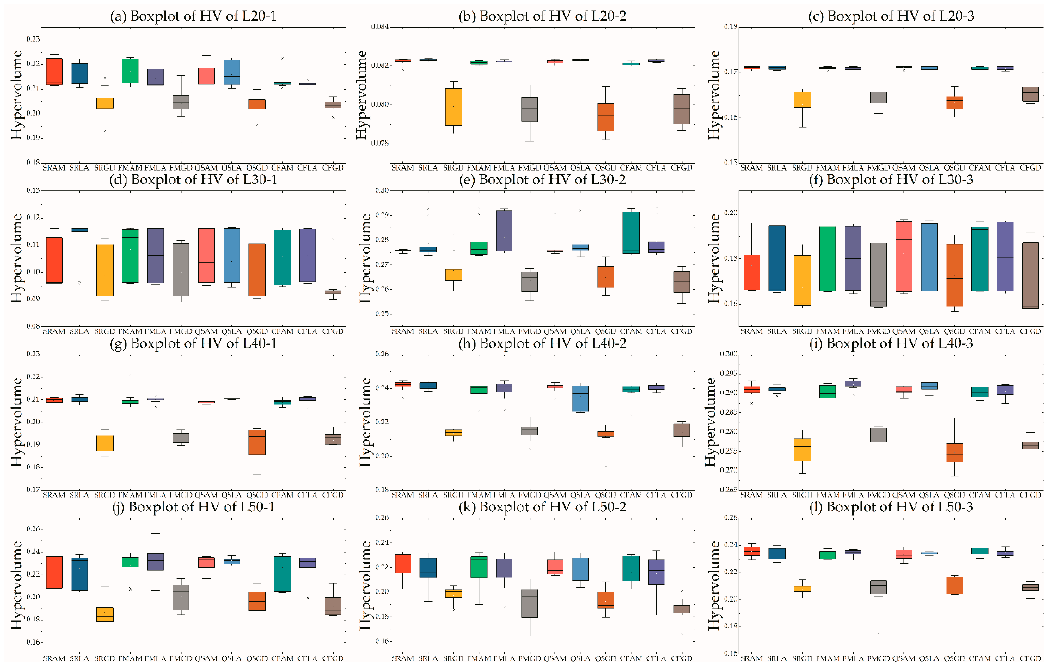
Figure 3. Boxplot of hypervolume values of 12 pairs.